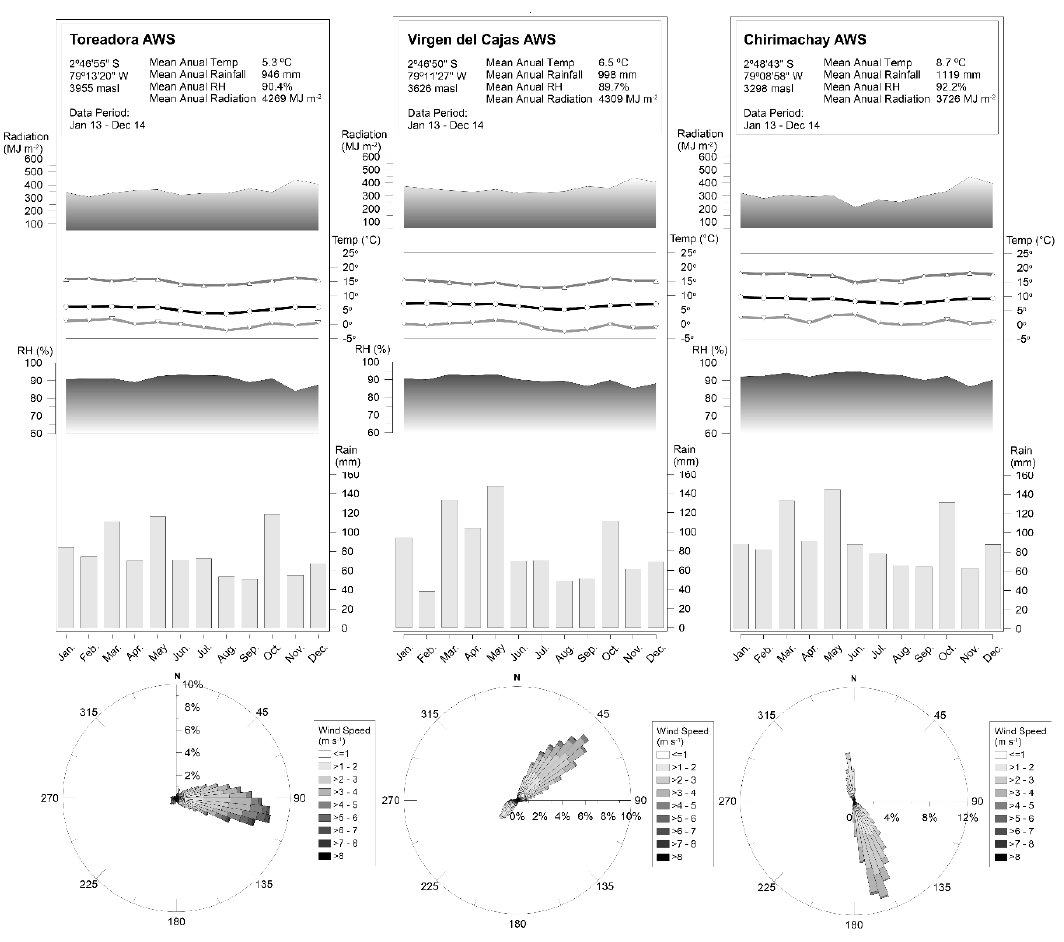
Figure 3. Quinoas automatic weather stations climographs (January 2013 to December 2014).